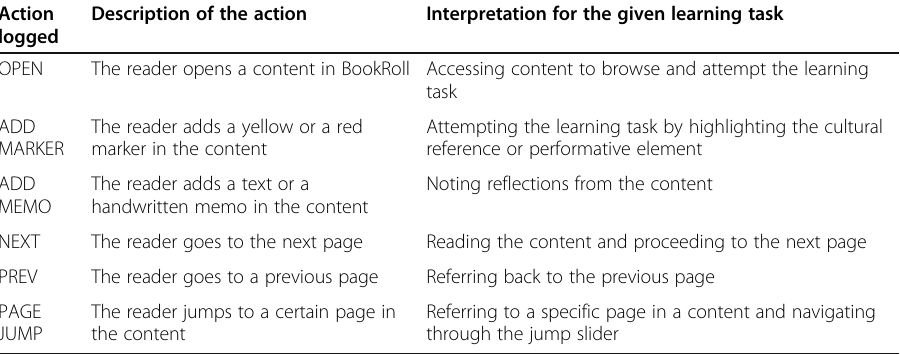
Table 1 Description and interpretations of the reading action logs Action